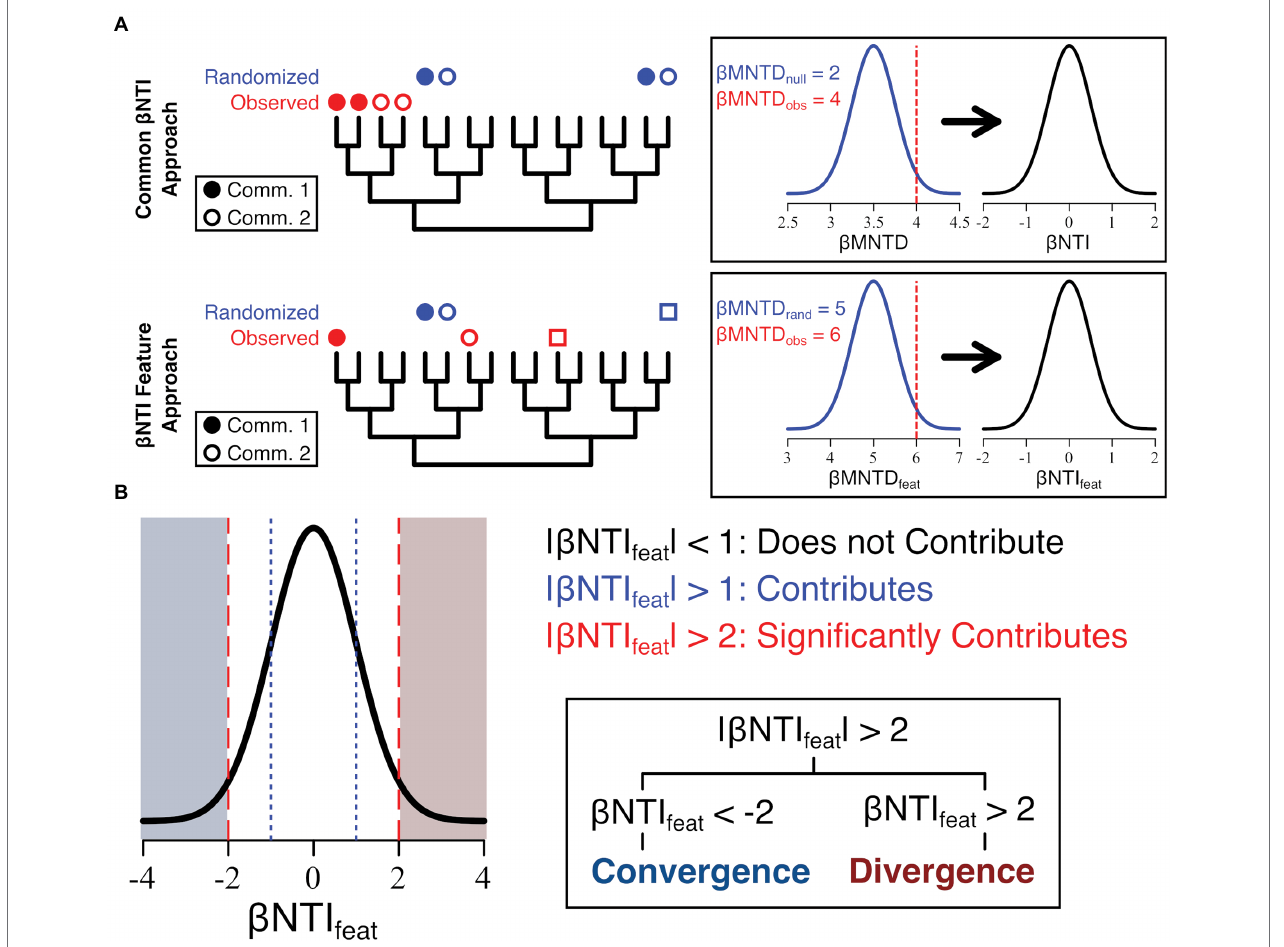
FIGURE 1 | Conceptual depiction of feature-level β -nearest taxon index ( β NTI feat ) calculation as it compares to the common β -nearest taxon index ( β NTI) calculation (A) and the subsequent interpretation (B) . Essentially, the β NTI feat calculation mirrors β NTI though instead measures the distance between a given focal feature in one community/assemblage (closed circles) and the nearest member in another community/assemblage (open circles and